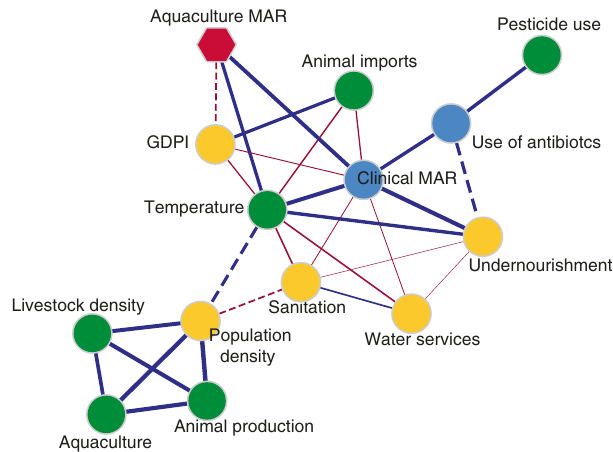
Fig. 4 Pearson correlation network between all the simple studied variables. Signi fi cant correlations ( P -value < 0.05) are displayed with solid lines, whereas correlations ( r > 0.30) nearing statistical signi fi cance (0.10 > P -value > 0.05) are shown in dashed lines. Edge weight is proportional to the correlation coef fi cient ( r ), with line width increasing with higher correlation values.